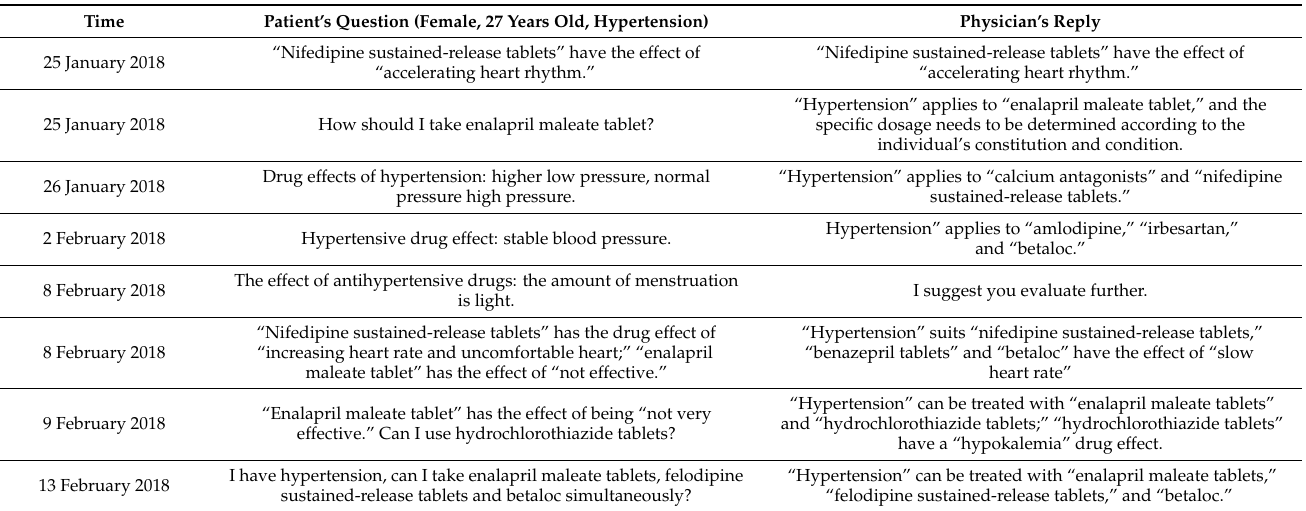
Table 6. Medication management information of a user’s DDEs and time